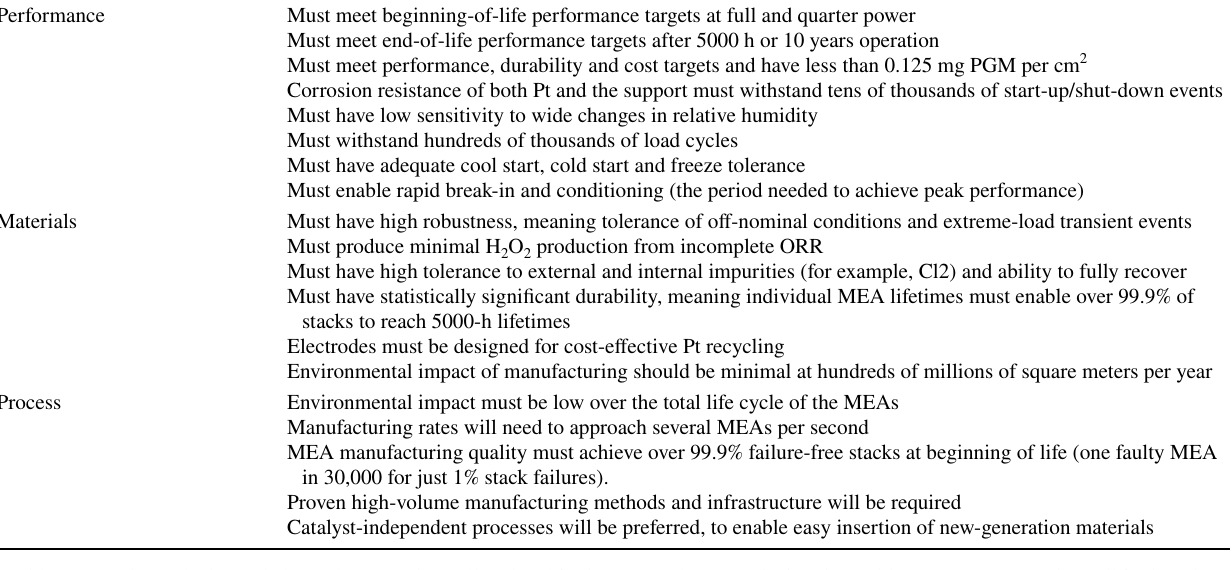
Table 2 Development criteria for automotive fuel cell electrocatalysts [51] Reproduced with permission from Publishers: Nature, Order Num- ber: 4638121383737 Title: Electrocatalyst approaches and challenges for automotive fuel cells, Mark K.